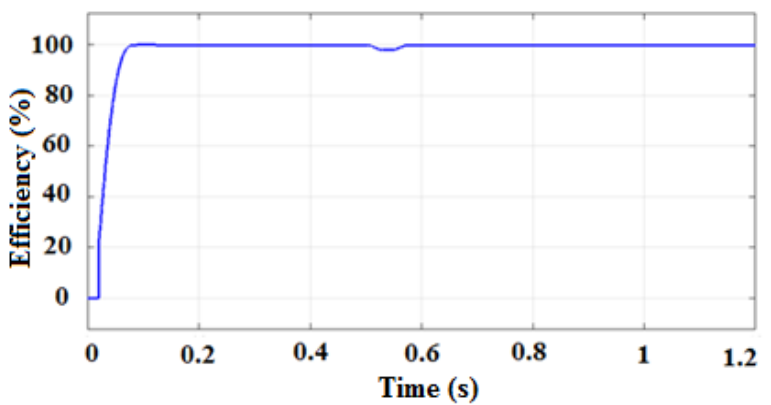
Figure 8. Efficiency of Neural Network – Improved Particle Swarm Optimization (NN – IPSO).